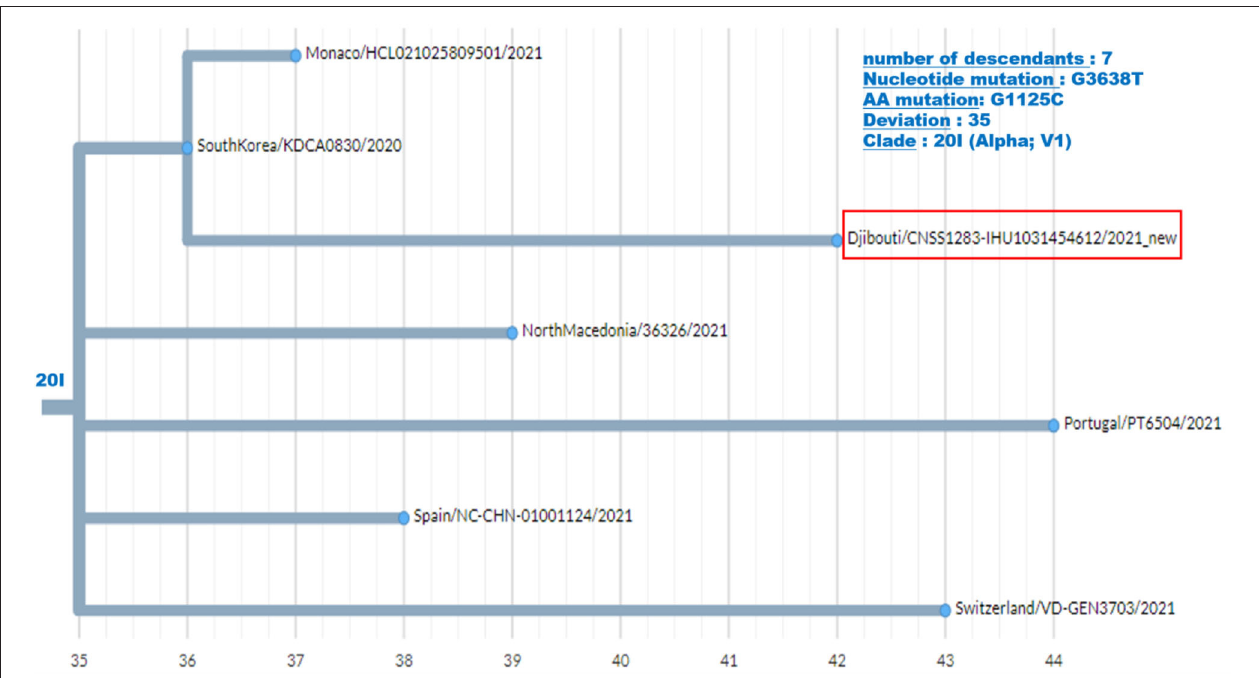
FIGURE 7 | Phylogenetic tree (obtained using the Nexcladevv0.14.4 software (https://clades.nextstrain.org/), including the UK variant of SARS-CoV-2 strain from the second COVID-19 wave in Djibouti compared to six SARS-CoV-2 sequences (clade 20I) available through GISAID. The scale at the bottom of the figure indicates the number of mutations (deviation) compared to the sequence of the reference strain (Wuhan-Hu-1 reference strain; GenBank accession no. NC_045512.2).